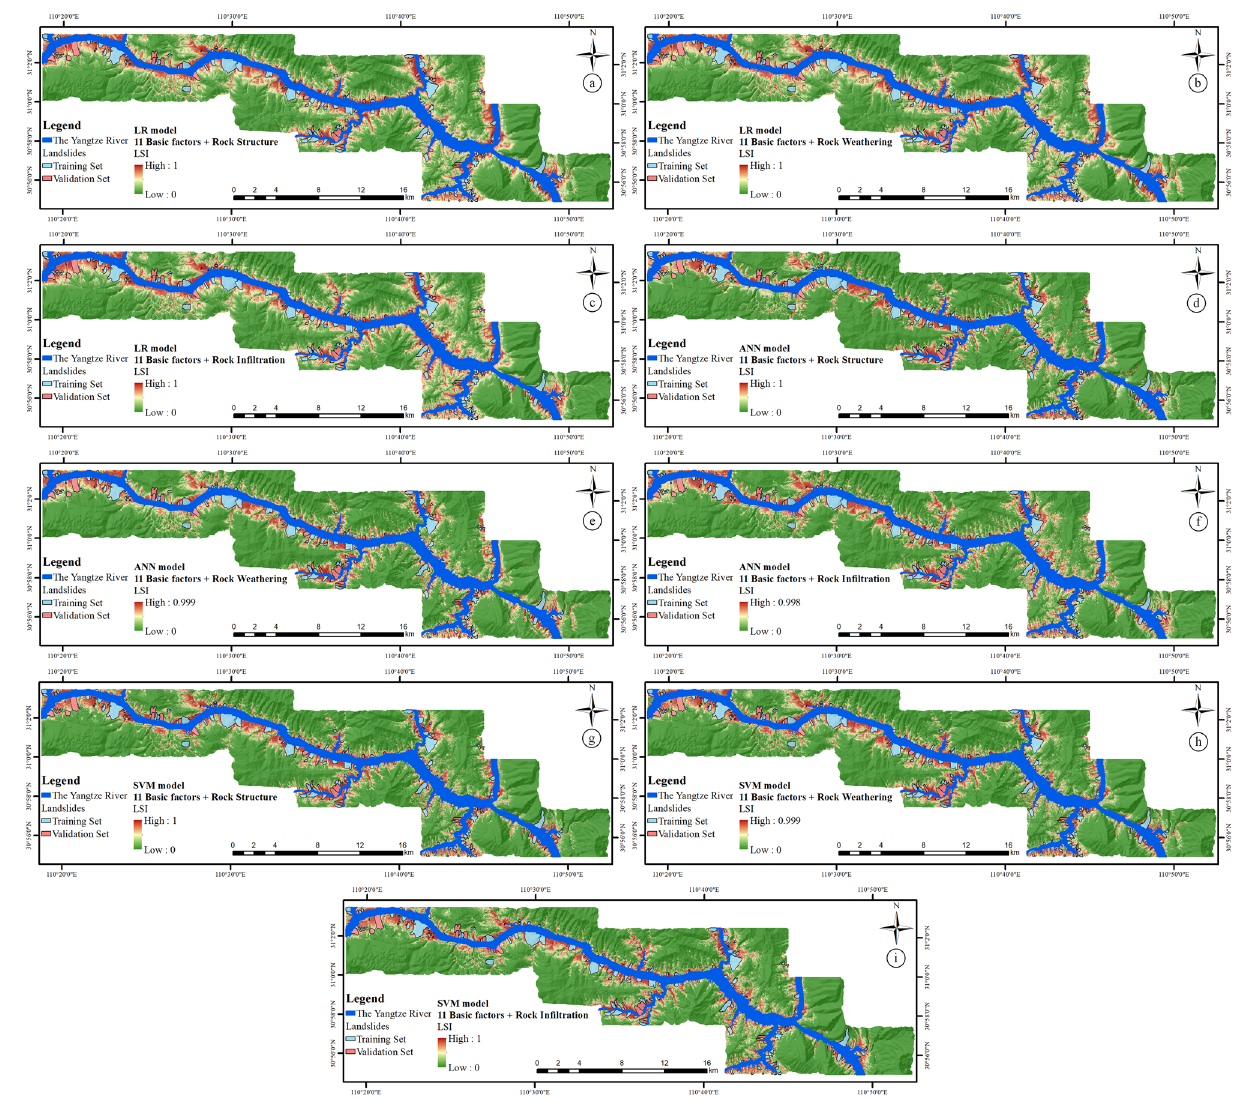
Figure 12. LSI based on the 11 basic factors and ( a ) rock structure factor by LR model, ( b ) rock weathering factor by LR model, ( c ) rock infiltration factor by LR model, ( d ) rock structure factor by ANN model, ( e ) rock weathering factor by ANN model, ( f ) rock infiltration factor by ANN model, ( g ) rock structure factor by SVM model, ( h ) rock weathering factor by SVM model, ( i ) rock infiltration factor by SVM